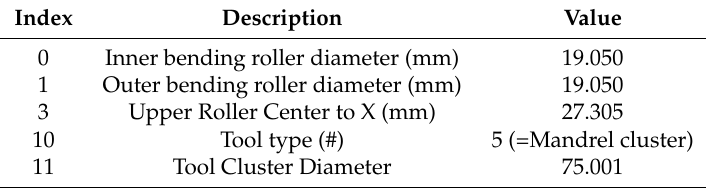
Table 4. Tool geometry setting values for increasing accuracy of bending